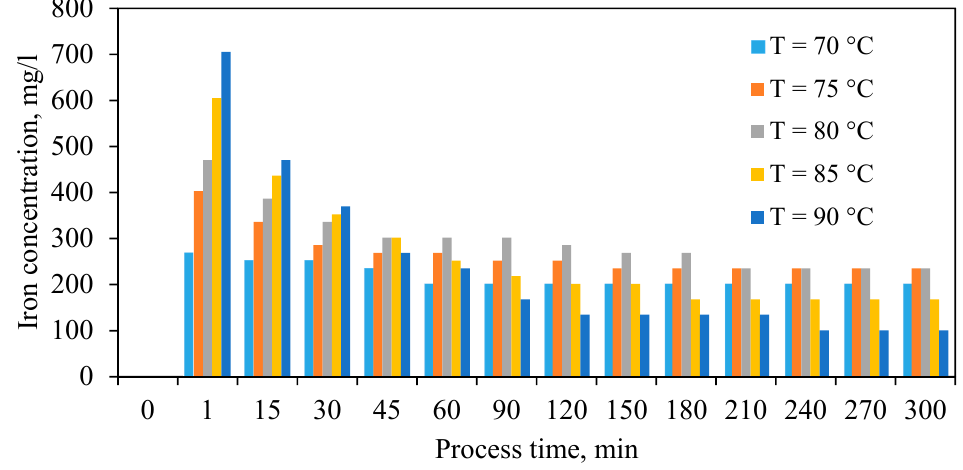
Figure 4. Changes in the concentration of iron during leaching experiments.